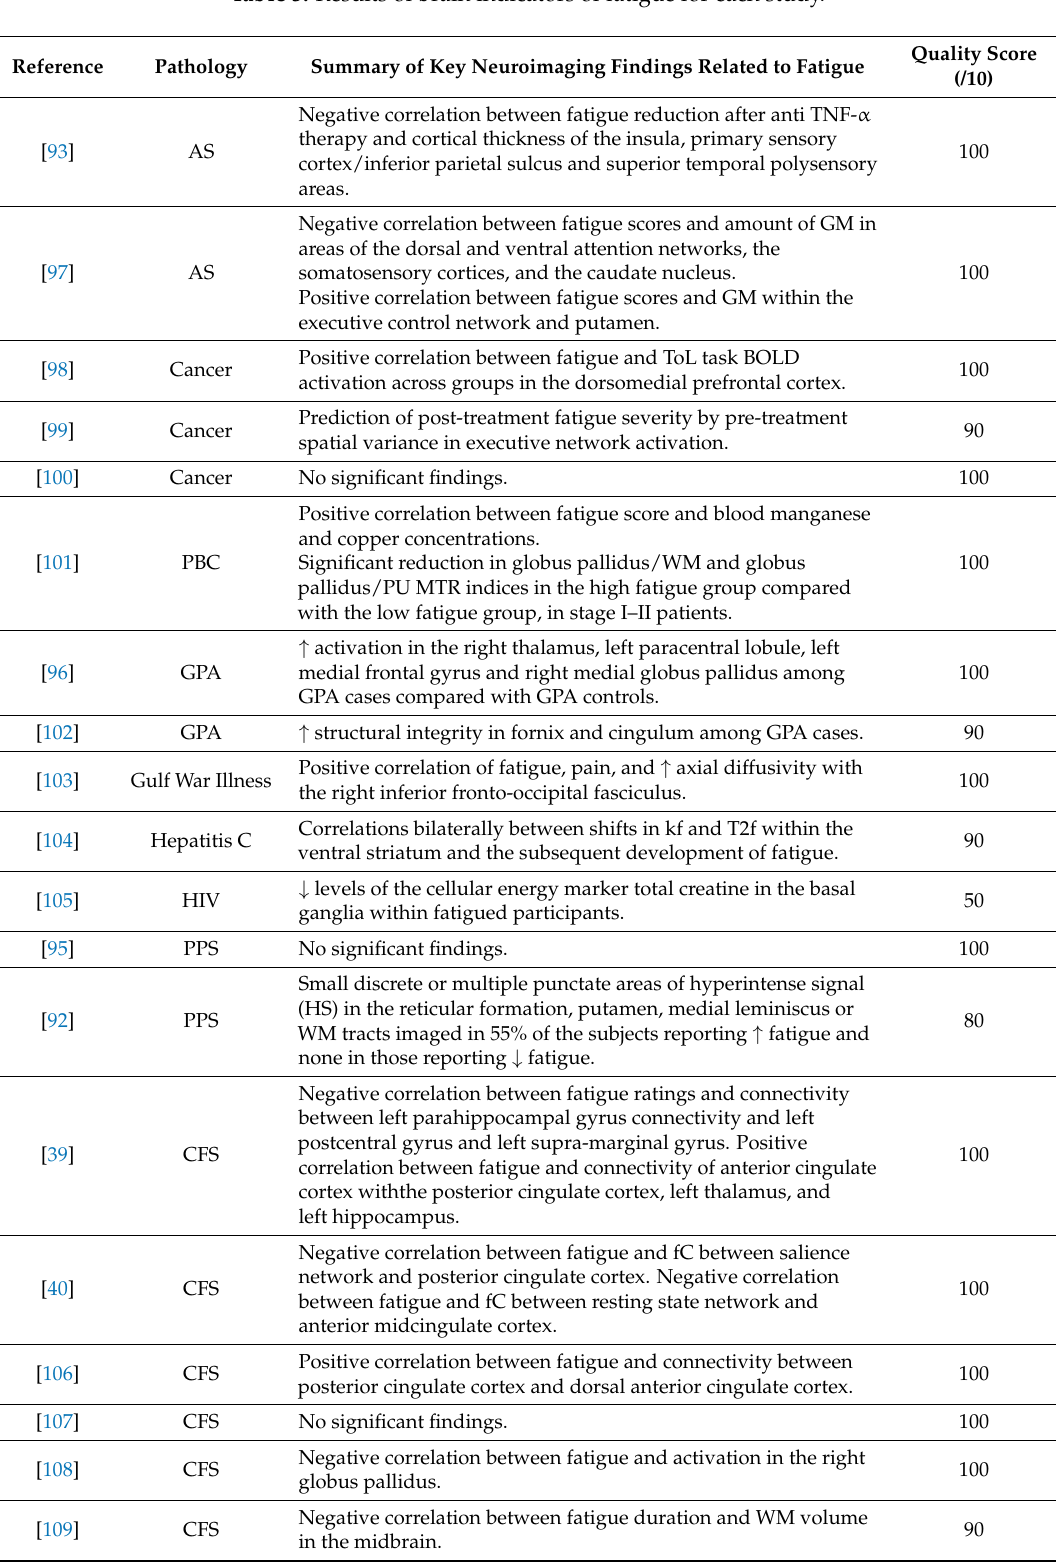
Table 3. Results of brain indicators of fatigue for each